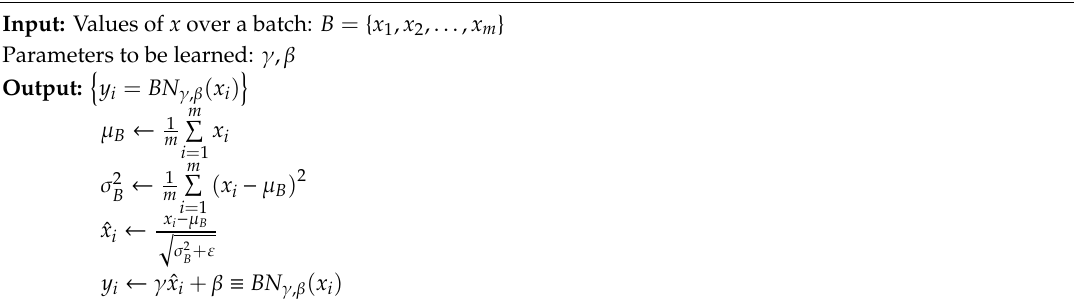
Algorithm 1 [25]. Batch Normalizing Transform, applied to activation x over a